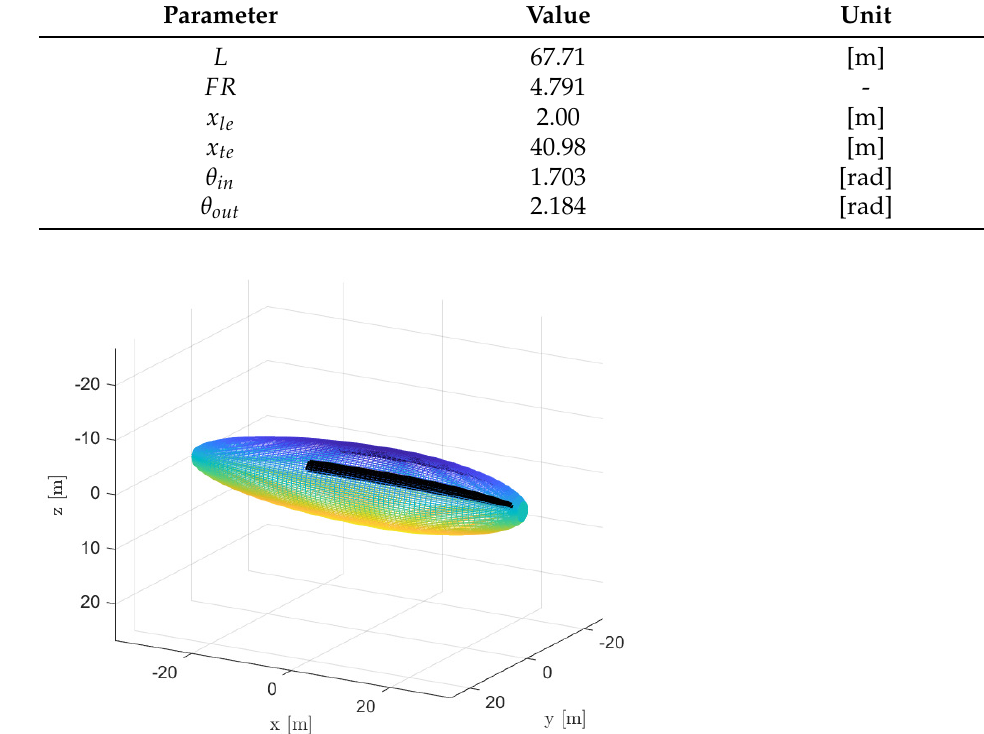
Figure 12. Optimal layout for operation at 18.06 km altitude above Port-au-Prince, Haiti.